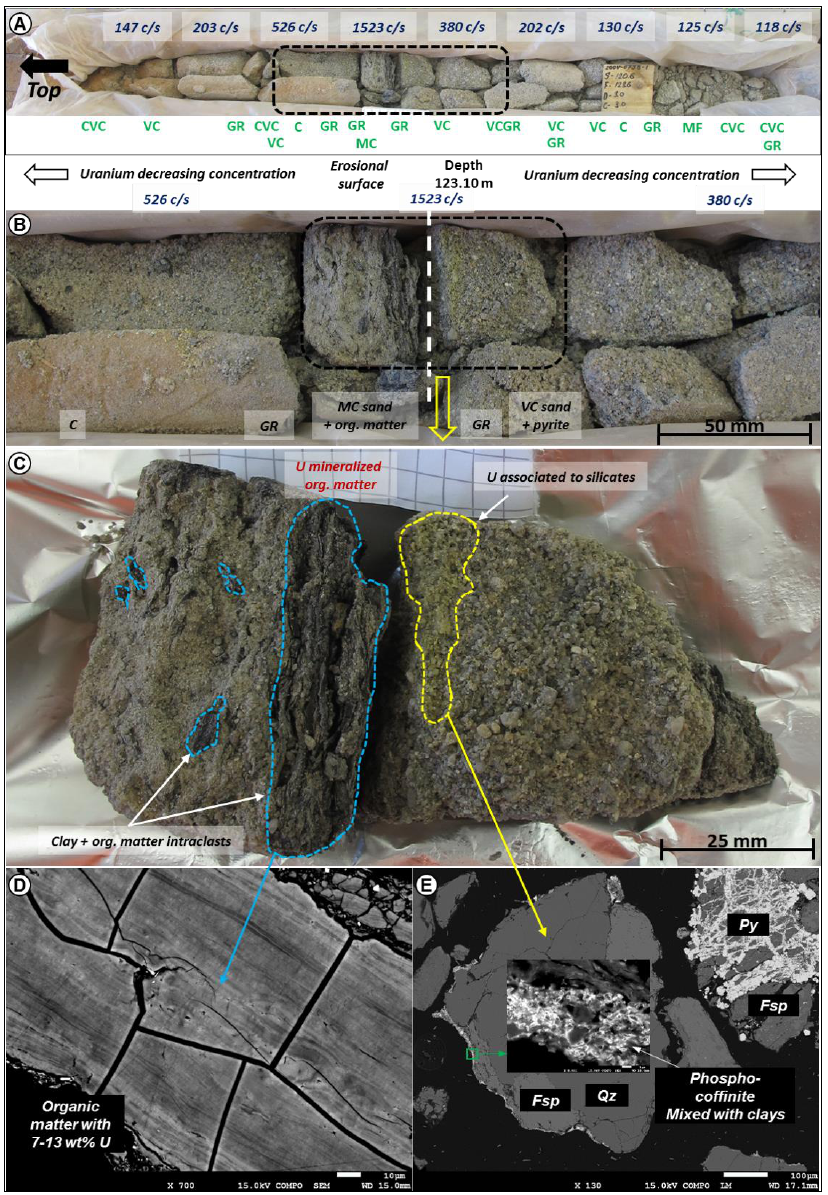
Figure 2. Abbreviations: GR (granules), CVC (coarse to very coarse sand), VC (very coarse sand), C (coarse sand), MC (medium coarse sand), Fsp (feldspar), Qz (quartz), Py (pyrite). ( A ) Drill-core